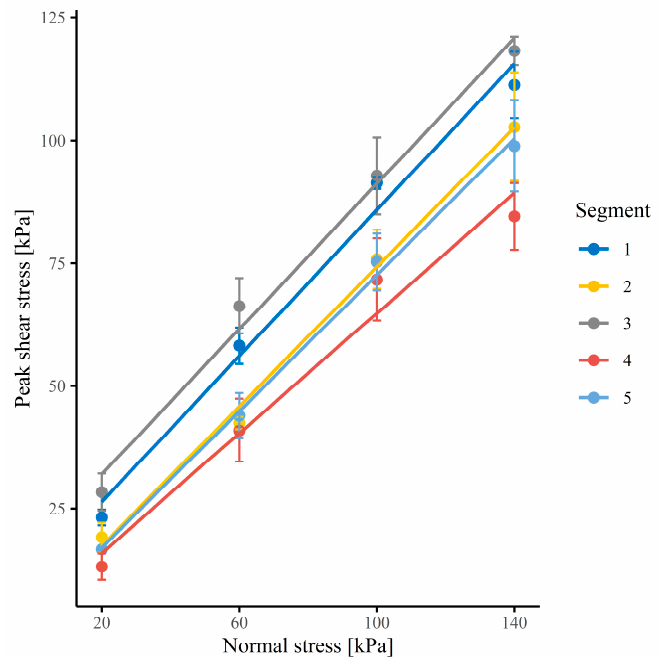
Figure 6. Shear strength of soil in ditch segments 1–5 obtained from the unsaturated direct shear tests. The vertical lines in the graphs indicate standard deviation, and the dots are average shear stress values ( n = 3).